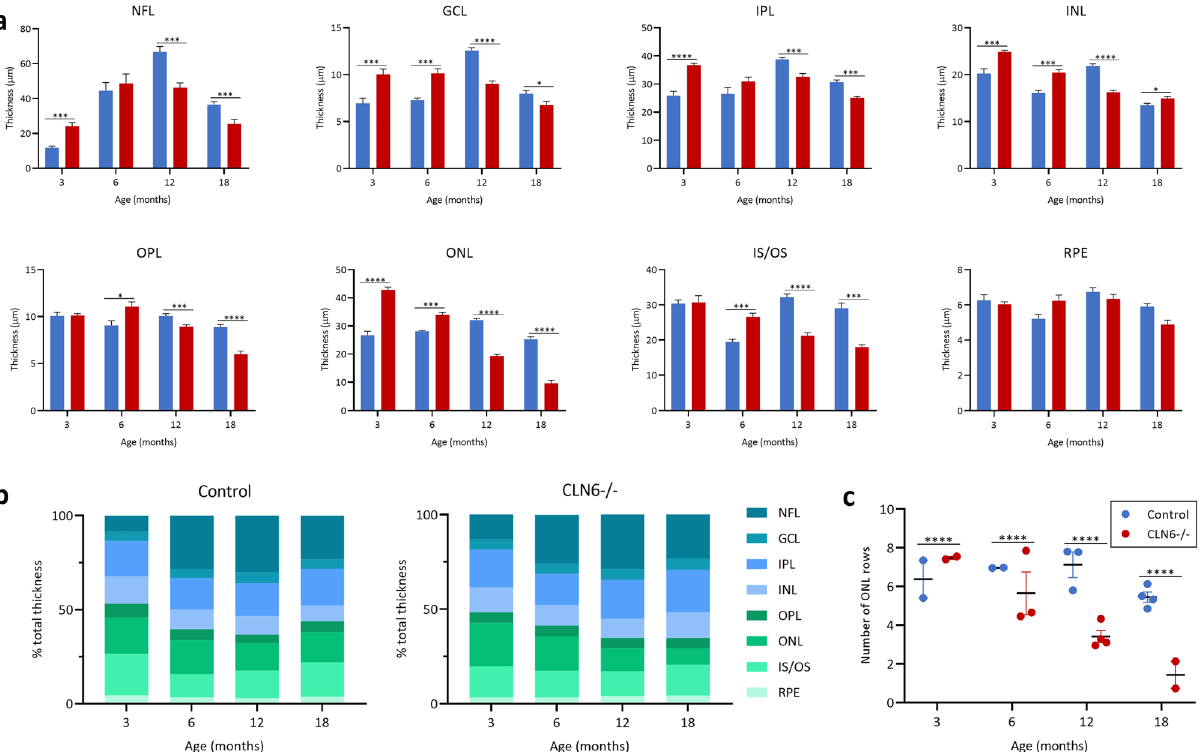
Figure 6. Thickness of individual retinal layers in healthy control and CLN6 −/− sheep at different ages. ( a ) Mean ± SEM thickness of individual layers in the central retina between control (n = 2–4, blue) and CLN6 −/− (n = 2–5, red) sheep at 3, 6, 12 and 18 months of age. ( b ) Percentage of total retinal thickness represented by each layer in control and CLN6 −/− sheep at various ages. ( c ) Mean ± SEM number of rows of cells in the outer nuclear layer (ONL) in control and CLN6 −/− sheep at various ages. * p < 0.05, *** p < 0.001, **** p < 0.0001. NFL; nerve fibre layer, GCL; ganglion cell layer, IPL; inner plexiform layer, INL; inner nuclear layer, OPL; outer plexiform layer, IS/OS; inner and outer segments of photoreceptors, RPE; retinal pigment